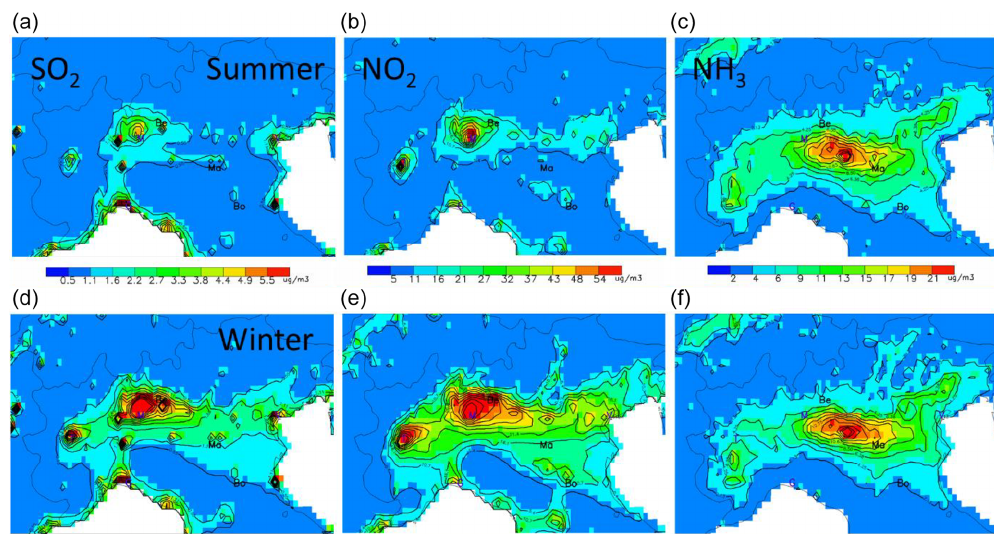
Figure 2. Summer (a, b, c) and winter (d, e, f) concentration base-case fields for SO 2 (a, d) , NO 2 (b, e) and NH 3 (c, f) expressed in µgm − 3 . The abbreviations Be, Ma and Bo represent the locations selected for more detailed analysis: Bergamo (Be), Mantua (Ma) and Bologna (Bo). Other cities are indicated by their first letter for convenience: Venice, Milan, Turin and